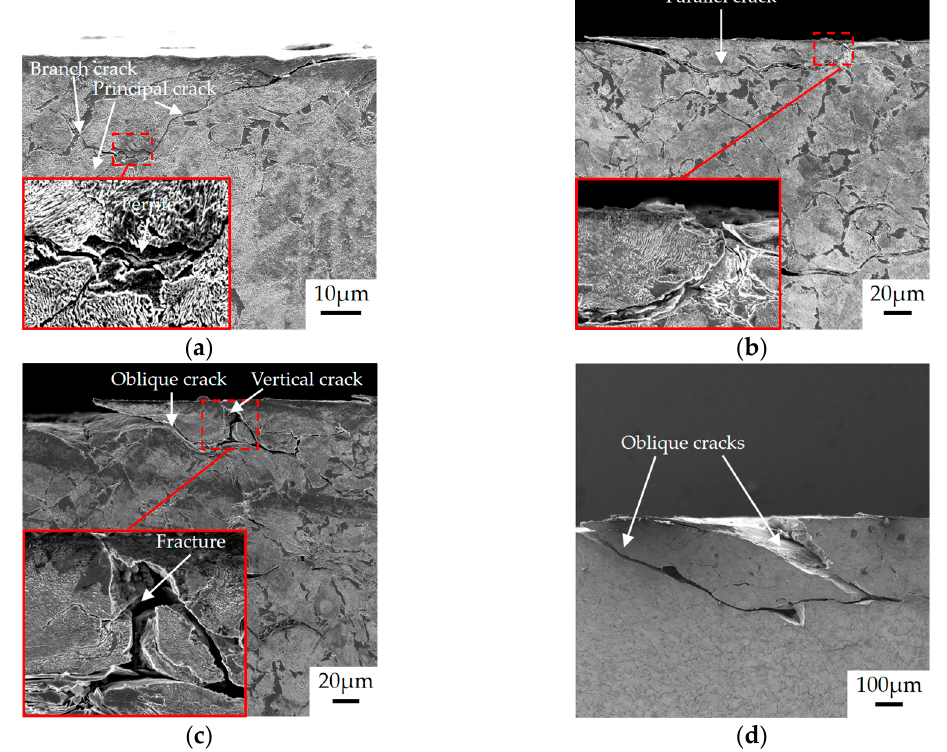
Figure 9. SEM images of cracks outside shelling: ( a ) branch crack grows back to surface; ( b ) parallel crack grows back to surface; ( c ) oblique and vertical cracks connect; ( d ) two oblique cracks connect.